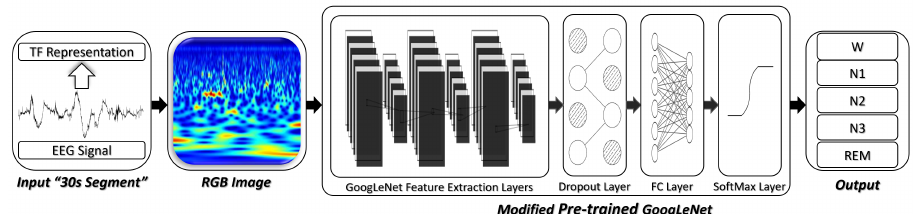
Figure 2. Deep CNN transfer learning approach for automatic scoring of sleep stages.